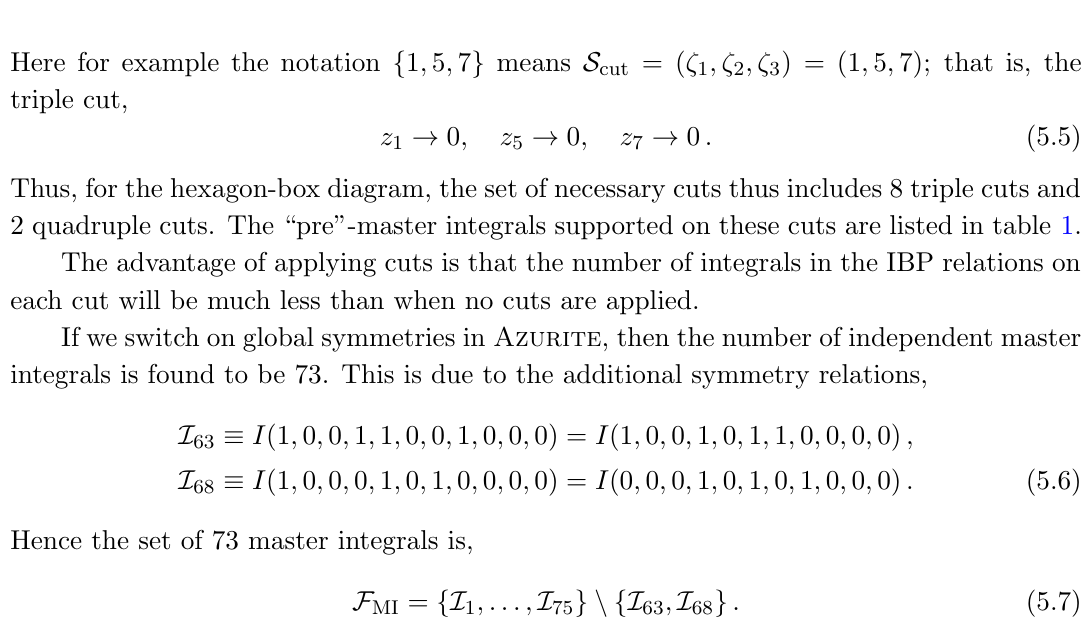
Table 1 . \Pre"-master integrals supported on each of the 10 cuts necessary to construct the complete IBP